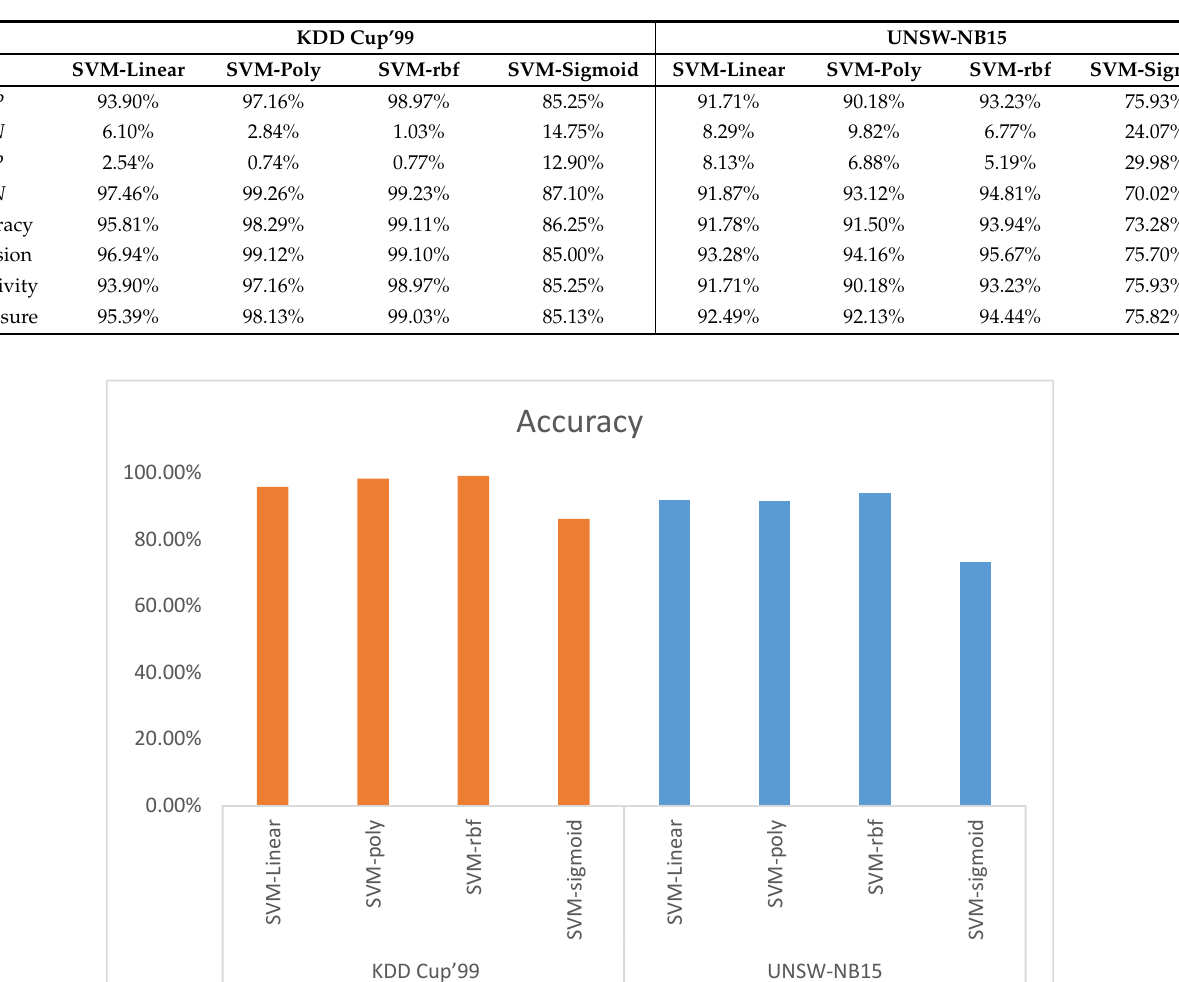
Figure 7. Accuracy.